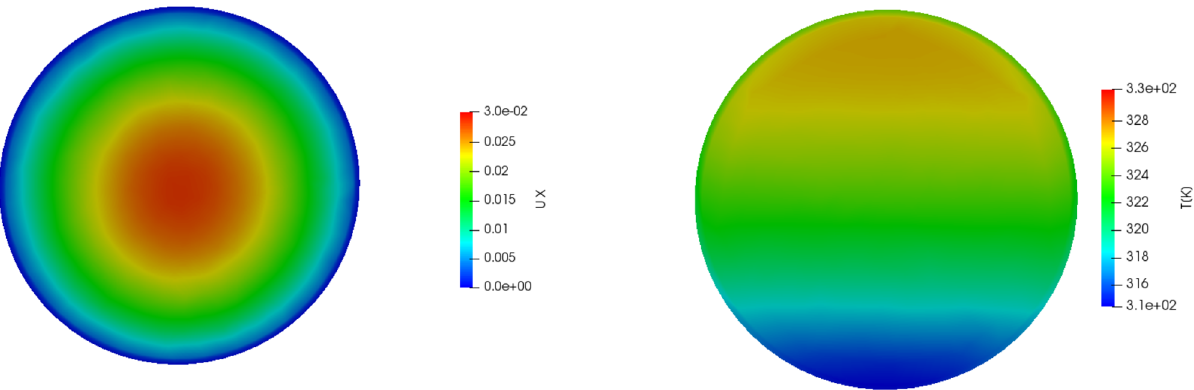
Fig. 12. Velocity (sx) and temperature (dx) profiles at the cooler inlet at t = 1000 s for k − ωSST turbulence model.